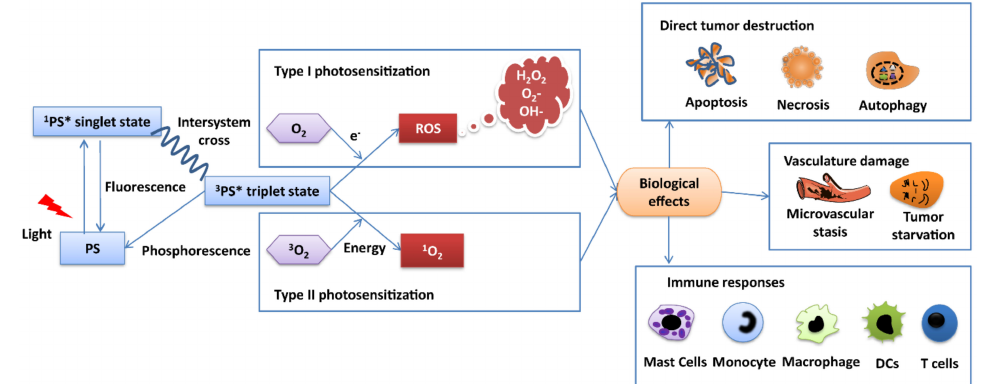
Figure 1. Mechanism of photodynamic therapy in cancer. The antitumor effects of PDT include three main mechanisms: PDT-induced cellular toxicity, vascular destruction, and immune response activation. When exposed to excitation wavelength light, the ground-state photosensitizer moves to a singlet state. In this state, PS can decay by emitting fluorescence, react with biological substrate, or undergo intersystem crossing, thereby being converted into a triplet state with longer life span (microseconds) and parallel spins. Triplet excited PS directly interacts with cell substate to generate toxic reactive oxygen species to directly kill tumor cells by inducing apoptosis, necrosis, or autophagy. PDT also induces tumor vasculature damage and immune responses. Abbreviations in figure: photosensitizer (PS), photosensitizer first excited state ( 1 PS*), photosensitizer triplet excited state ( 3 PS*), water (H 2 O), triplet oxygen ( 3 O 2 ), singlet oxygen ( 1 O 2 ), reactive oxygen species (ROS), hydrogen peroxide (H 2 O 2 ), superoxide anions (O 2 − ), hydroxyl radicals (OH −